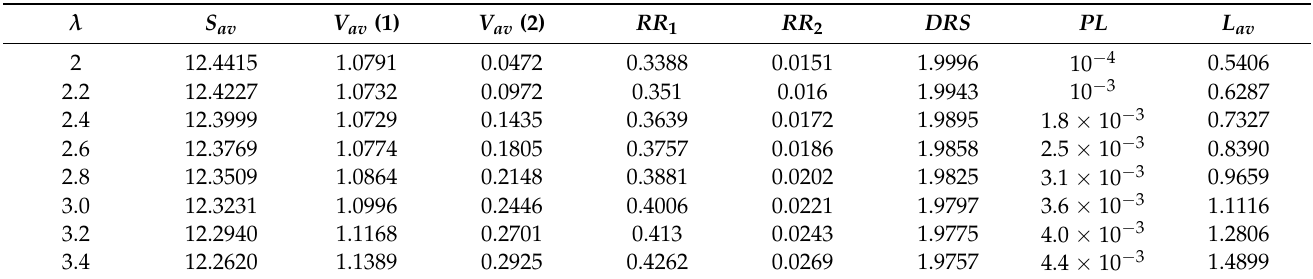
Table 1. Dependence of the performance measures on parameter λ ; µ 1 = 5, µ 2 = 6, κ = 2, τ = 2, ν 1 = 3, ν 2 = 5, r = 3, s = 8, S = 18.